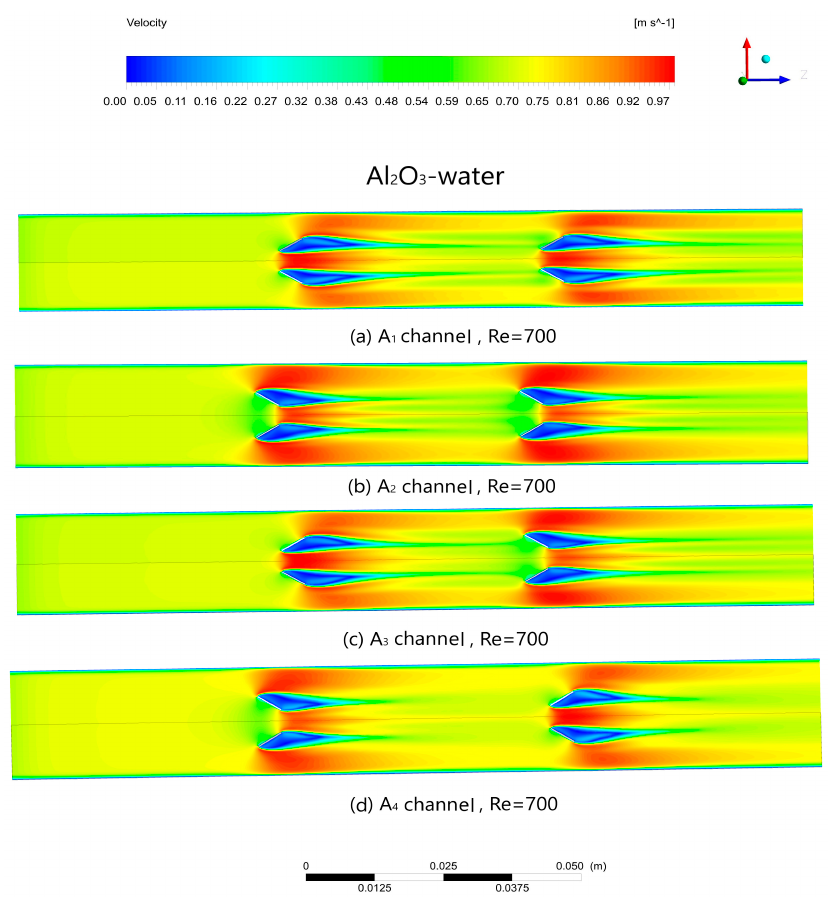
Figure 9. Streamlines for various configurations of a microchannel at Re = 700 for ( a ) A 1 , ( b ) A 2 , ( c ) A 3 and ( d ) A 4 .